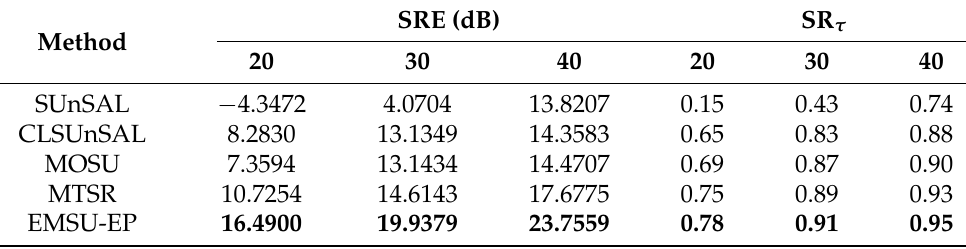
Table 1. Comparison of EMSU-EP with other algorithms on data 1. The value of τ is set to